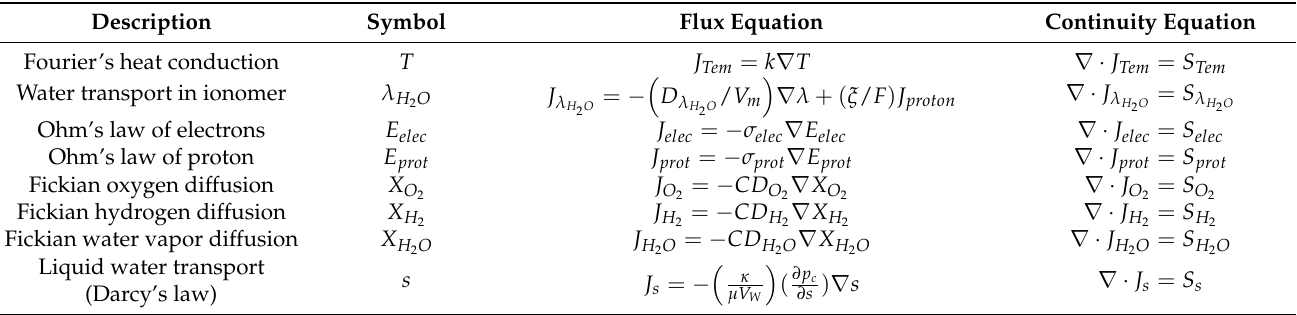
Table 1. Governing equations.